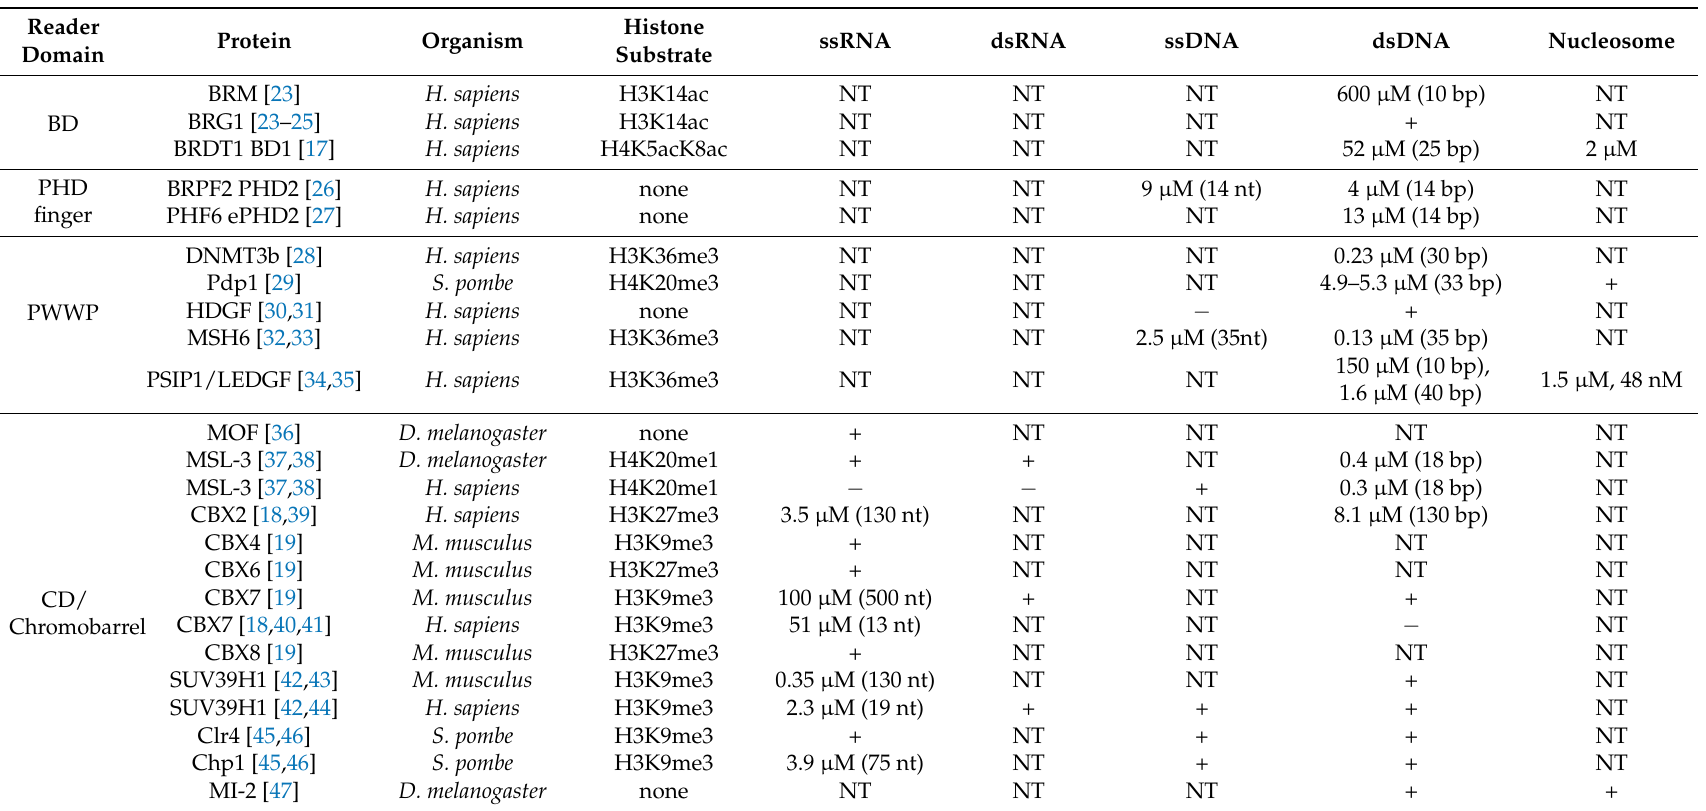
Table 1. Nucleic acid binding domains. The domain, protein, and histone substrate is indicated. Dissociation constants for nucleic acids are shown if known, or indicated as (+) for detected binding with no determined affinity. Lack of binding is indicated by ( − ). NT indicates not tested. Nucleic acid substrates include single stranded (ss) or double-stranded (ds) RNA or DNA or